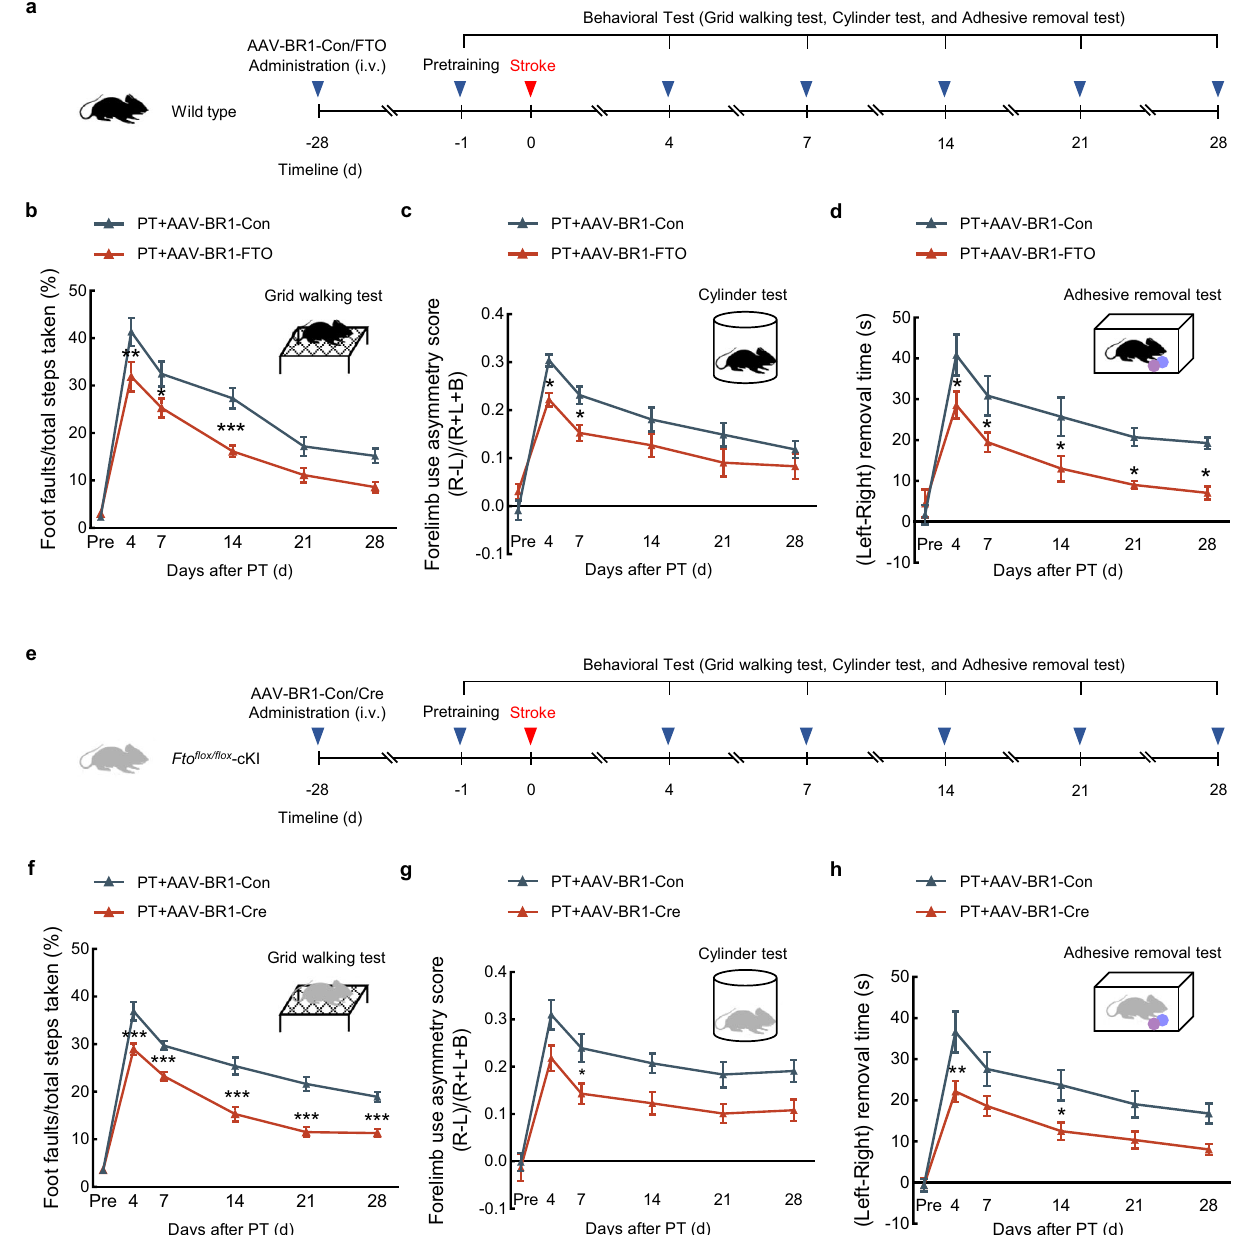
Fig. 7 | Endothelial-targeted FTO overexpression promoted motor functional recovery in PT mice. a Schematic of AAV-BR1-FTO administration and behavioral analysis. b – d Endothelial-targeted FTO overexpression improved behavioral recovery at different time points after PT as measured by the grid-walking test, cylindertest, and adhesive removaltest. Lindicates left forepaw incylinder test;R, right forepaw in cylinder test; B, both forepaws in cylinder test. n =19 mice for PT+AAV-BR1-CongrouporPT+AAV-BR1-FTOgroup. * P =0.0408(7d), ** P =0.0039 (4d), *** P =0.0005 (14d) versus the PT+AAV-BR1-Con in b . * P =0.0400 (4d), * P =0.0444(7d)versusthePT+AAV-BR1-Conin c. * P =0.0391(4d), * P =0.0391(7d), * P =0.0347 (14d), * P =0.0391 (21d), * P =0.0391 (28d) versus the PT+AAV-BR1-Con